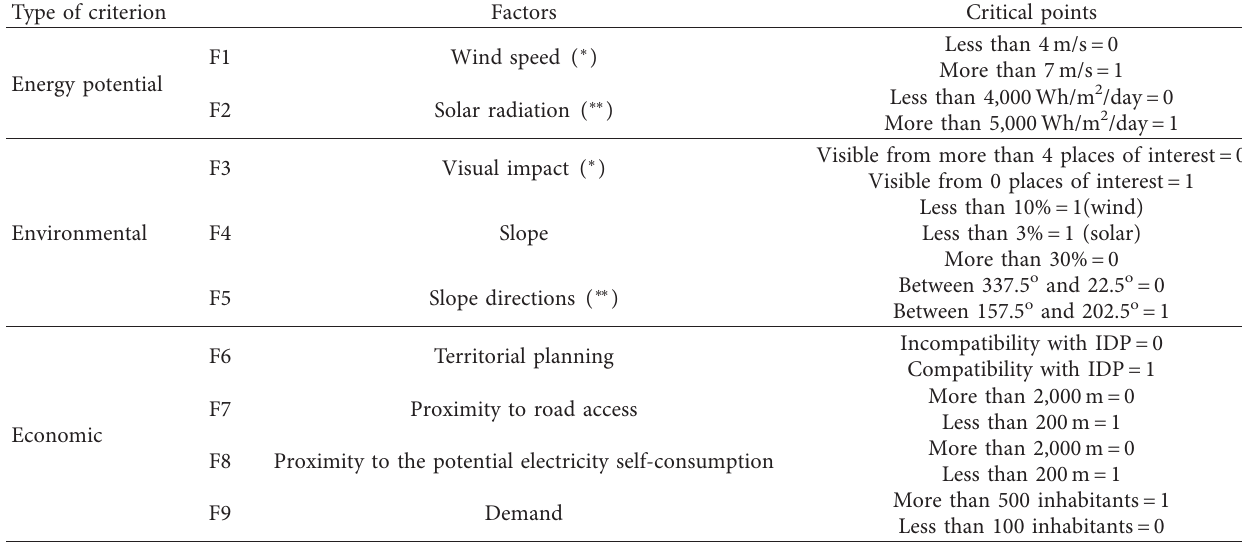
Figure 2: Methodological framework. Table 1: Classification of